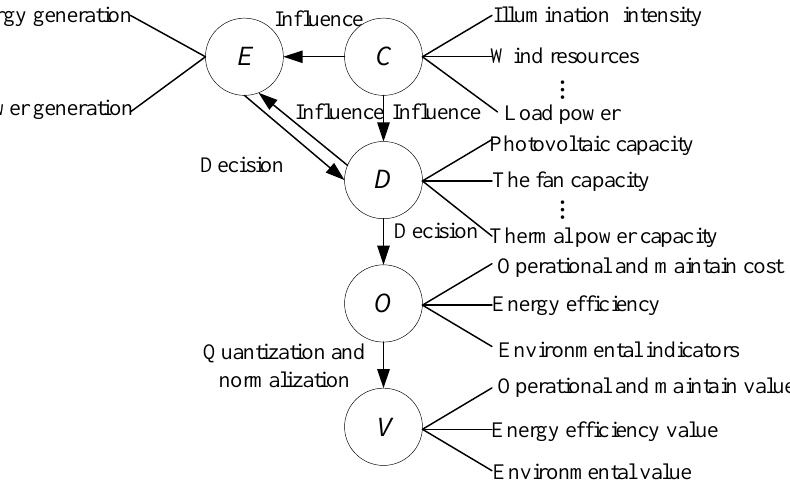
Figure 4. Schematic diagram of the model in network form.